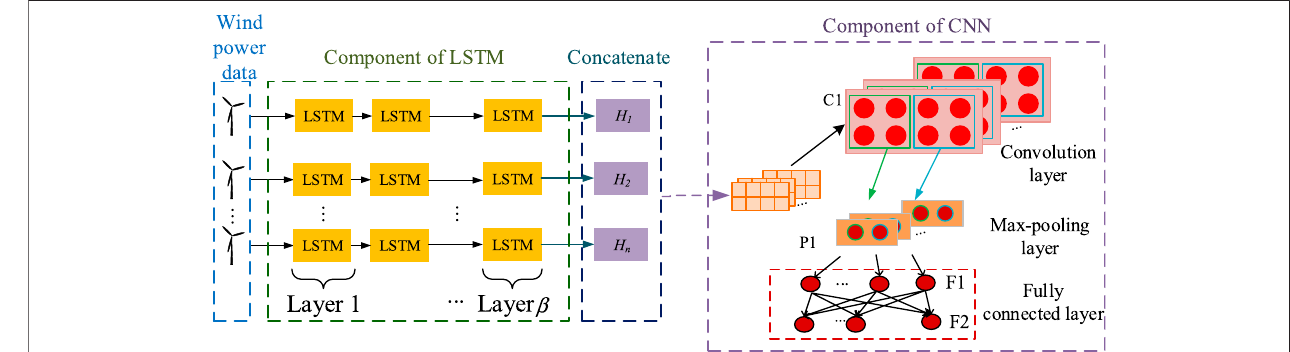
FIGURE 1 | The LSTM-CNN joint prediction model.